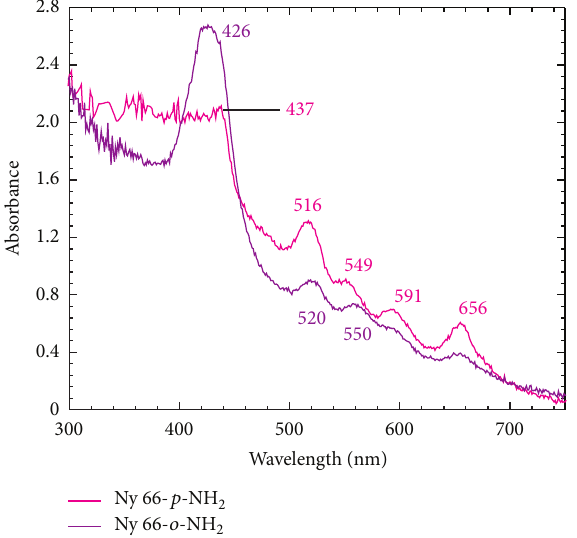
Figure 9: UV-Vis spectra of dry Ny 66- o -NH 2 and Ny 66- p -NH 2